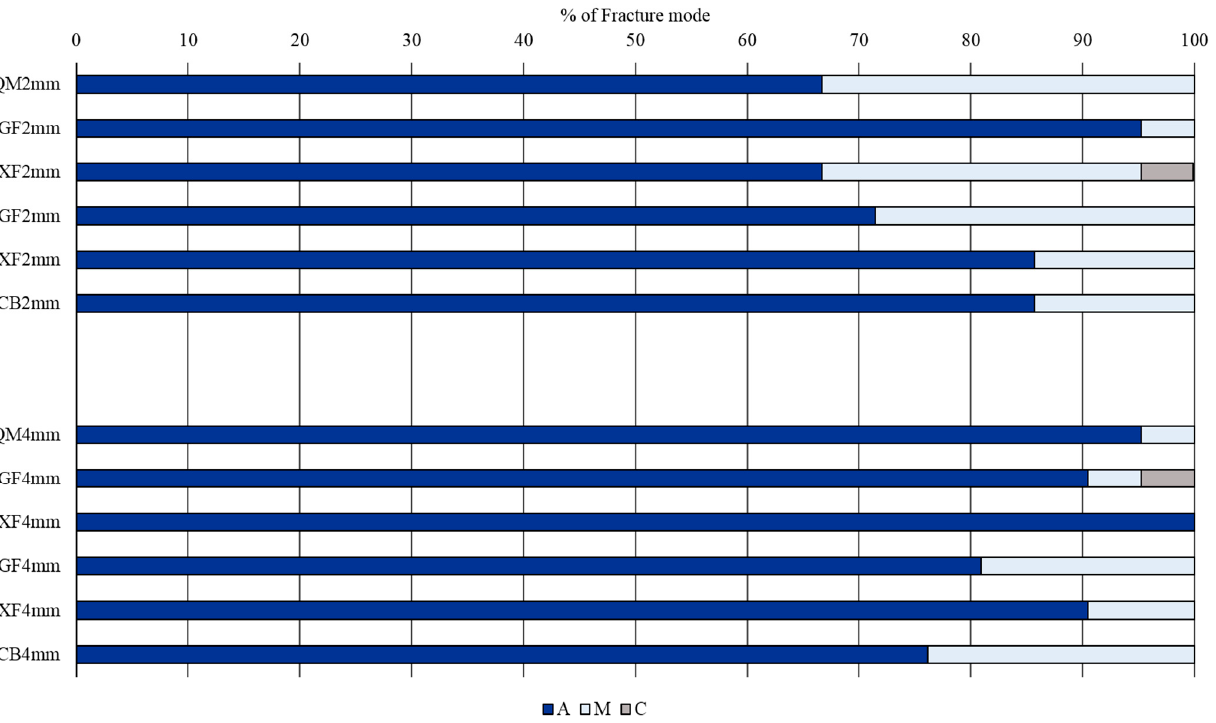
Figure 4. Representative stereomicroscope images for the different failure modes (40×). ( A ) Adhe- sive failure mode. ( B ) Mixed failure mode. ( C ) Cohesive mode of failure. 3.3. Resin Composite Film Thickness For the FT, within each resin composite, statistical analysis showed that there was no statistically significant difference between 2 mm and 4 mm CAD/CAM thicknesses ( p > 0.05). For this reason, the film thickness was statistically analyzed regardless of the thick- ness of the CAD/CAM resin composites, and the whole 12-rods were used to calculate the film thickness for each resin composite material. The data were statistically analyzed us- ing one-way ANOVA and Tukey’s HSD post-hoc test. Table 3 showed that XF resin com- posite showed the significant highest film among all resin composites ( p < 0.05). The VCB showed statistically significant higher FT compared to BFQM, GF, HXF, and HGF ( p < 0.05). There was no statistically significant difference between BFQM, GF, and HXF or between GF and HGF ( p > 0.05).